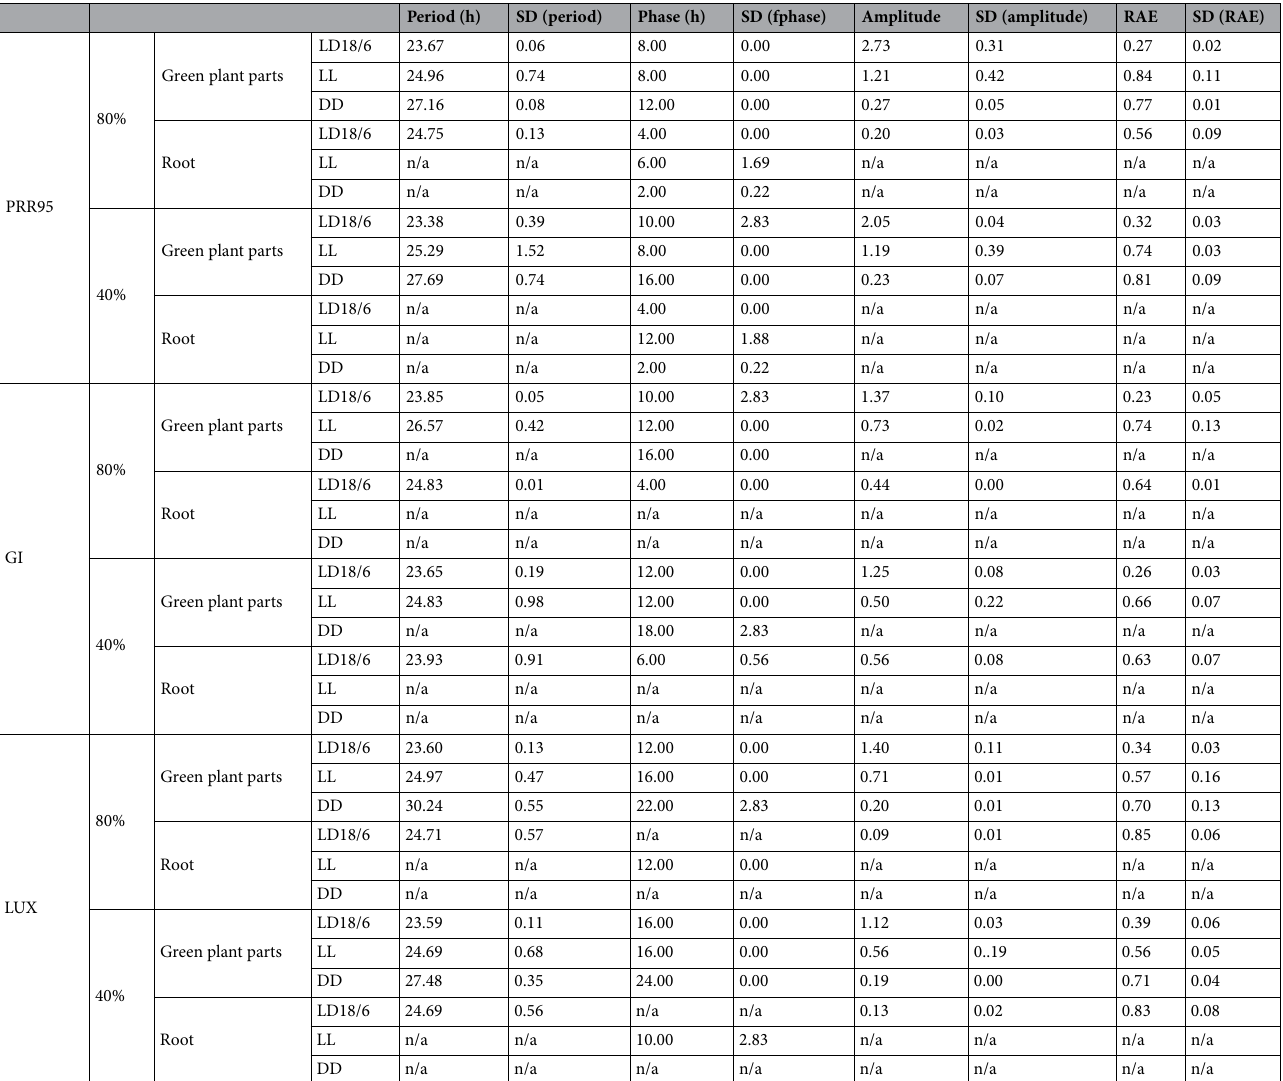
Table 2. Periods, phase and amplitudes and RAE values of time course gene expression of PRR95 (Bradi4g36077), GI (Bradi2g05226) and LUX (Bradi2g62067) in green plant parts and roots. Period and RAE values were estimated with BRASS software from the whole dataset (ZT2 to ZT78) for the individual time-course expression curves measured by qRT-PCR. Phase: time of expression maxima with reference to daybreak. Amplitude: twice the average distance from the mean expression maxima. RAE: relative amplitude error; Fourier fit to experimental data varying between 0 (perfect fitted rhythm) and 1 (rhythm not significant). Values are means ± SD from two biological replicates. n/a: no data result from data analysis. LD: 18:6 light:dark cycles. LL: 24:0 light. DD: 0:24 dark. 80%: well-watered conditions; 80% relative soil water content. 40%: drought stress conditions; 40% relative soil water